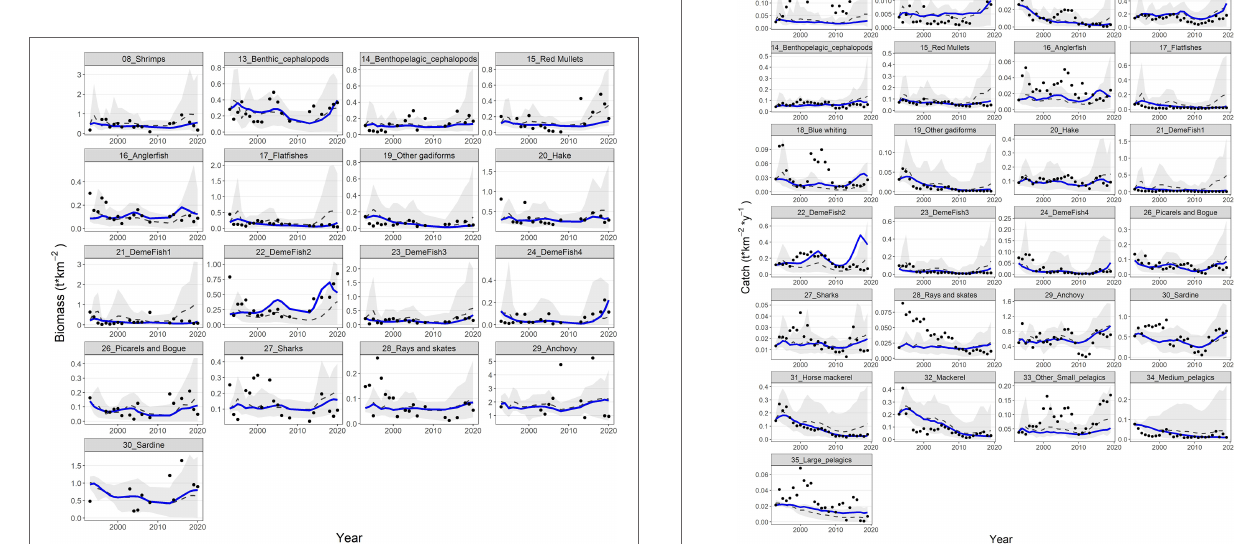
FIGURE 7 | Predicted (blue lines) and observed (dots) catches for 25 FGs with available catch time series. Dashed grey lines and shaded areas are the mean and the 5%-95% percentiles of the 100 Monte-Carlo simulations